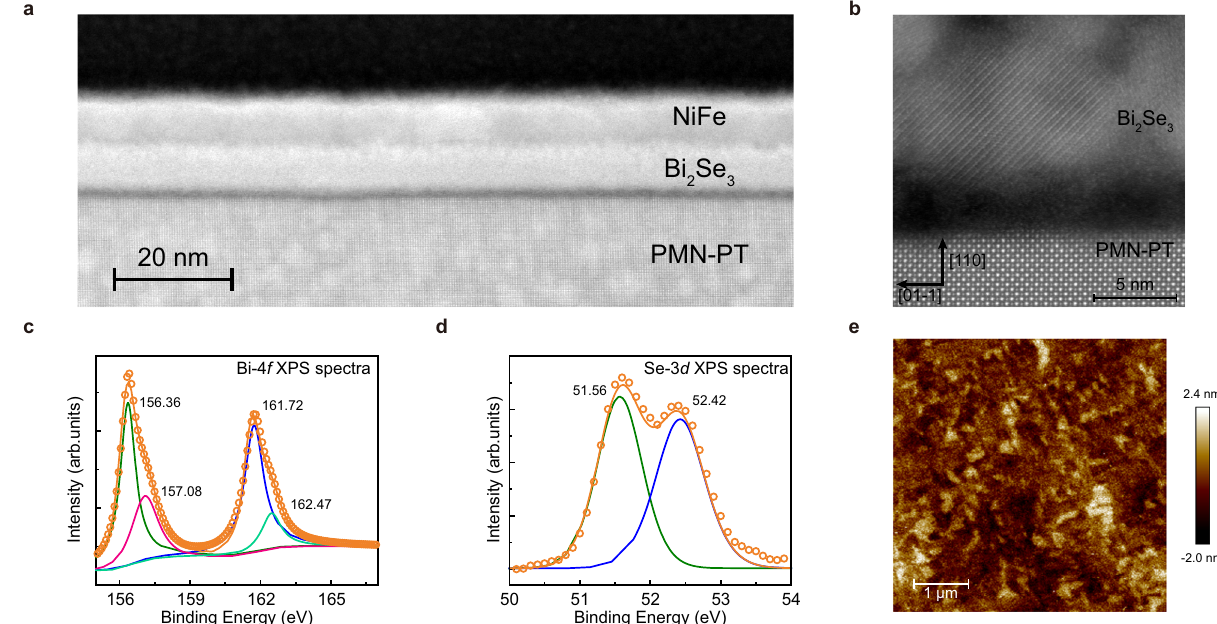
Fig. 1 Structure, element and surface morphology characterization of the fi lm. a Low magni fi cation and ( b ) high-resolution cross-sectional HAADF- STEM image of PMN-PT/Bi 2 Se 3 /NiFe. The XPS spectra for the Bi 2 Se 3 fi lm where ( c ) Bi-4 f core level and ( d ) Se-3 d core level. e AFM morphology of PMN- PT/Bi 2 Se 3 /NiFe